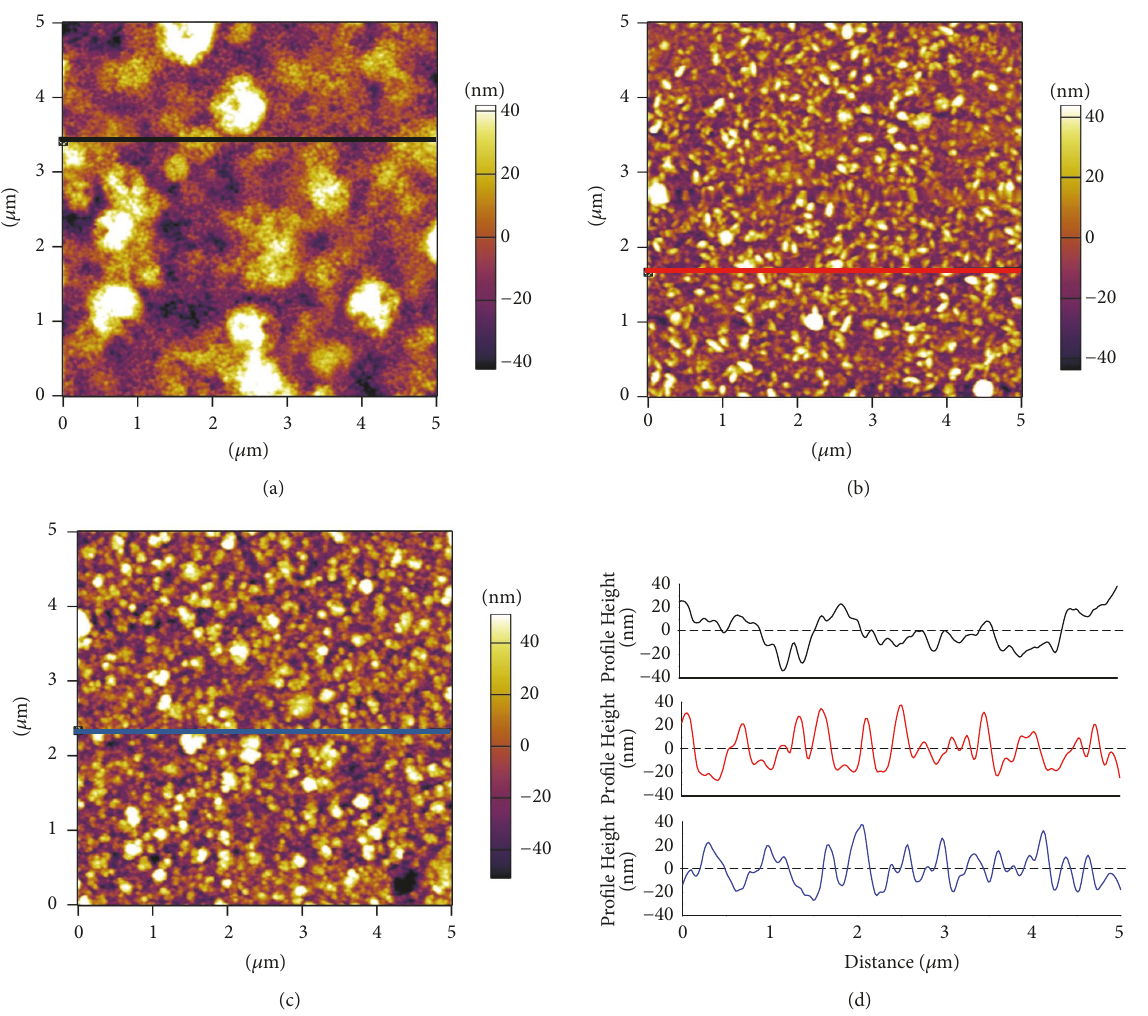
Figure 4: AFM pictures of ZnO films with thicknesses of 200 nm deposited at substrate temperatures of 150 ∘ C (a), 200 ∘ C (b), and 250 ∘ C (c) along with the surface profiles taken at denoted